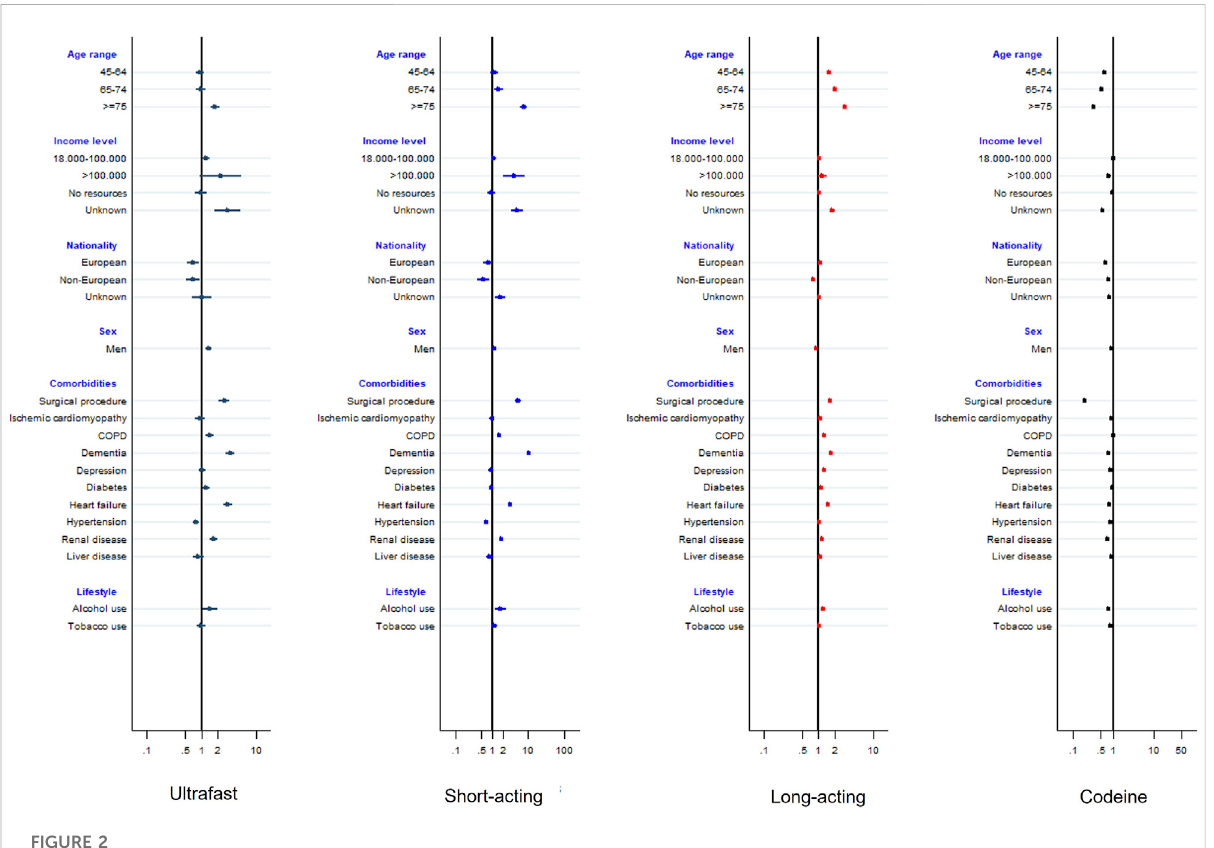
Forest plot of the multinomial regression (reference: